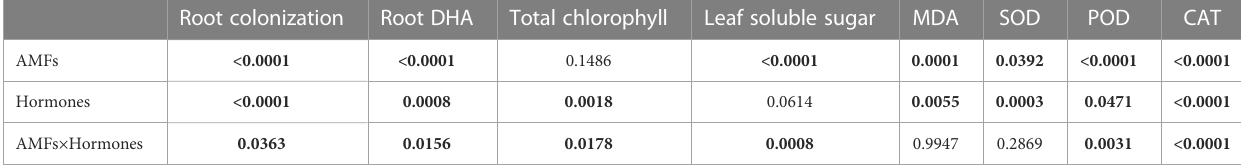
TABLE 1 Analysis of variance (ANOVA) of different variables after treatment with AMFs and hormones. Root